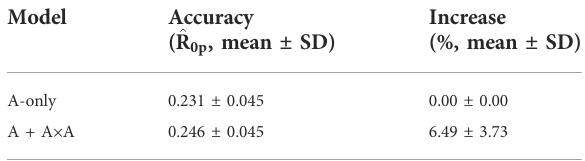
TABLE 2 Accuracy of predicting RFI phenotypic values in validation